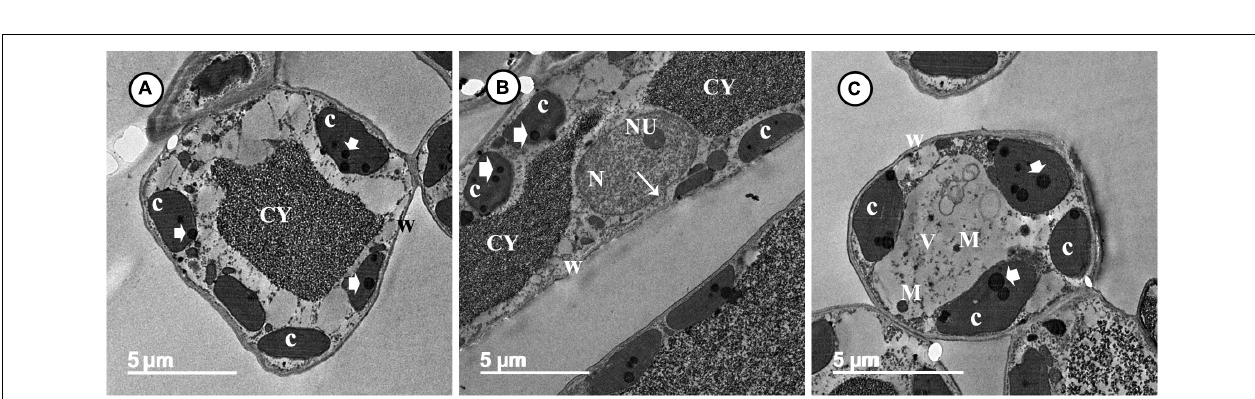
FIGURE 4 | Transmission electron micrographs of grapevine leaf cells infected with P. viticola after the treatment by SiNPs. Where (A) A normal grapevine cell showing normal chloroplasts (C) with electron-dense plastoglobuli (arrowheads). Note a normal thin wall (W) and granulated cytoplasm (CY). Bar = 5.0 µ m. (B) A normal grapevine cell showing normal chloroplasts (C) with electron-dense plastoglobuli (arrowheads). Note a normal thin wall (W) and granulated cytoplasm (CY). Note also a normal nucleus (N) with nucleolus (NU) surrounded by a nuclear envelope (arrow). Bar = 5.0 µ m, and (C) A normal grapevine cell showing normal chloroplasts (C) associated with the cell wall (W) and contain electron-dense plastoglobuli (arrowheads). Note unknown electron-dense materials (M) located in cell vacuole (V). Bar = 5.0 µ m.